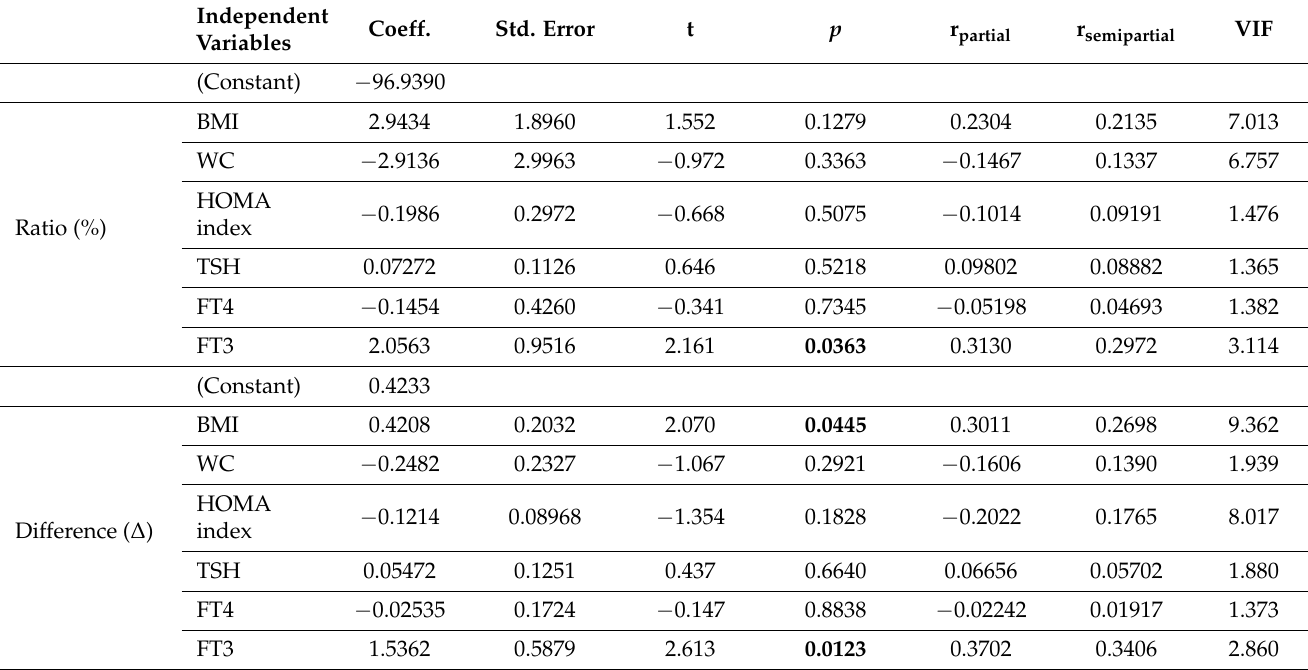
WC, waist circumference.